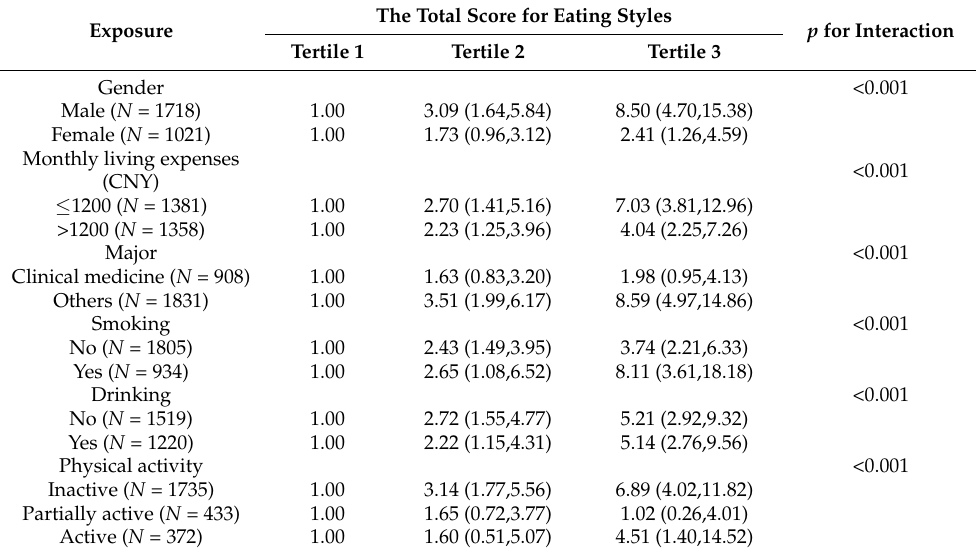
Table 5. Stratified analyses for association between the total score for eating styles and irritable bowel syndrome ( n =